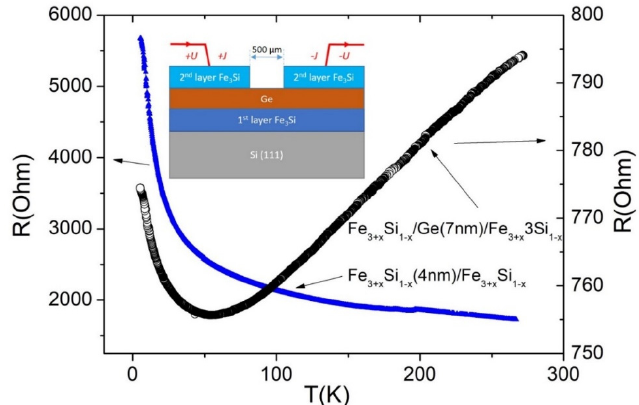
Figure 13. Temperature dependences of resistance of Fe 3+ x Si 1 − x /Ge(4nm)/Fe 3+ x Si 1 − x and Fe 3+ x Si 1 − x /Ge(7nm)/Fe 3+ x Si 1 − x etched structures . It can be seen from Figure 13 that the temperature dependence of the resistance for sample #6 “Ge 4 nm” is due to the conductivity of the thermoactivation type. However, fitting in Arrhenius coordinates (ln (R) vs. 1/T) does not give a good linear fit. The best linearization is obtained using R = R 0 exp(T 0 /T 1/4 ) (Figure 14), which suggests that the hop- ping type of conduction with variable hopping length (VRH) [57] prevails over the ther- mal delocalization of carriers and their transfer to the conduction band of germanium. The calculated parameter T 0 is 65 K, which is typical for “inhomogeneous” materials [58]. The dominance of the VRH mechanism is most likely due to the small thickness of the Ge interlayer and, accordingly, the high density of defects, that may indicate a partial island- like character of the film. Measured magnetoresistance curves R(H) at temperature 4 K in parallel and perpendicular magnetic field (not shown here) found no differences that is an additional argument for the 3-dimensional VRH transport mechanism. Figure 14. Fitting of temperature dependence of resistance of Fe 3+ x Si 1 − x /Ge(4nm)/Fe 3+ x Si 1 − x etched structure.